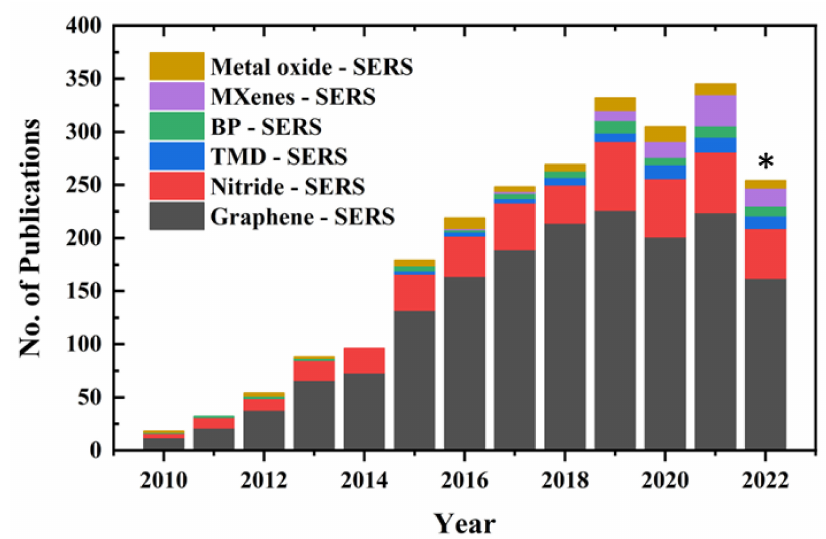
Figure 1. An indicative trend in number of publications on 2DNS-based SERS in the last decade. The search with the keyword “SERS” was refined with “Graphene, Nitrides, Transition-metal dichalco- genides, Black Phosphorus, MXenes and Metal Oxides”, separately. * Data obtained from ISI Web of Science on 27 November